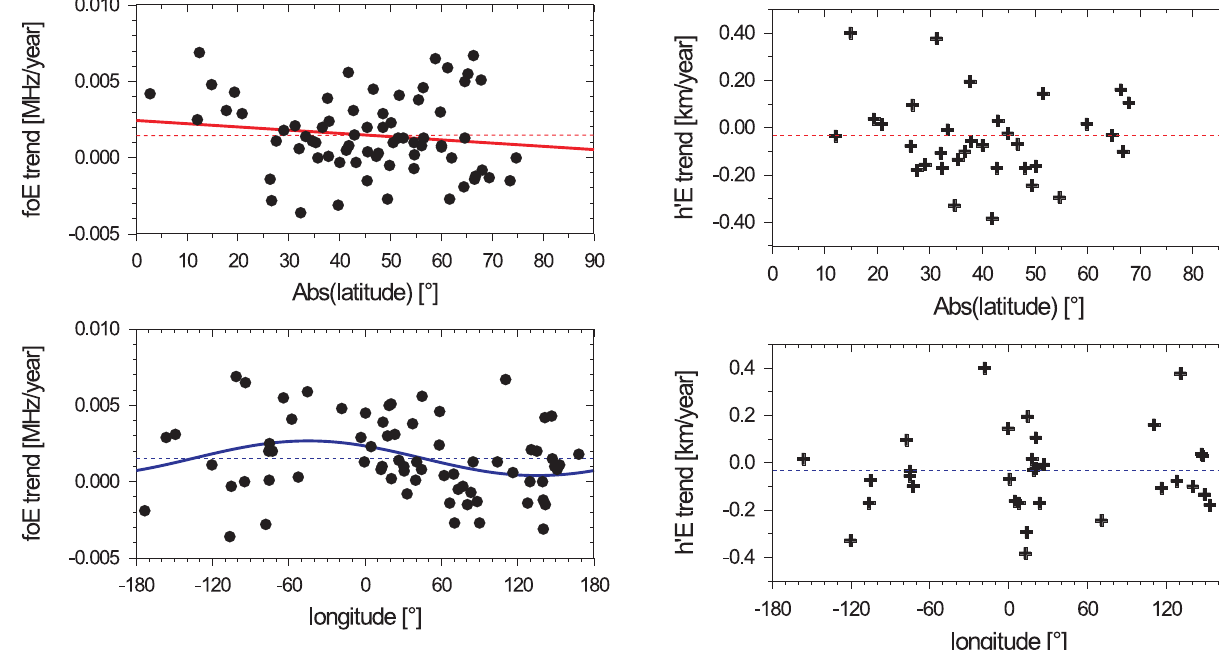
Fig. 8. h’E trends in dependence on the absolute value of the lati- tude of the individual stations (upper part) and on the longitude of these stations (lower part). The dashed lines characterize the mean global h’E